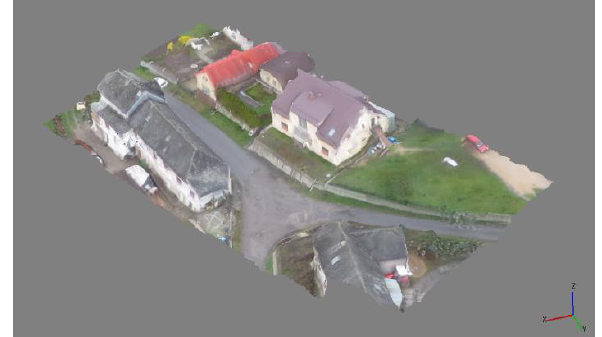
Figure 4. The textured digital model of